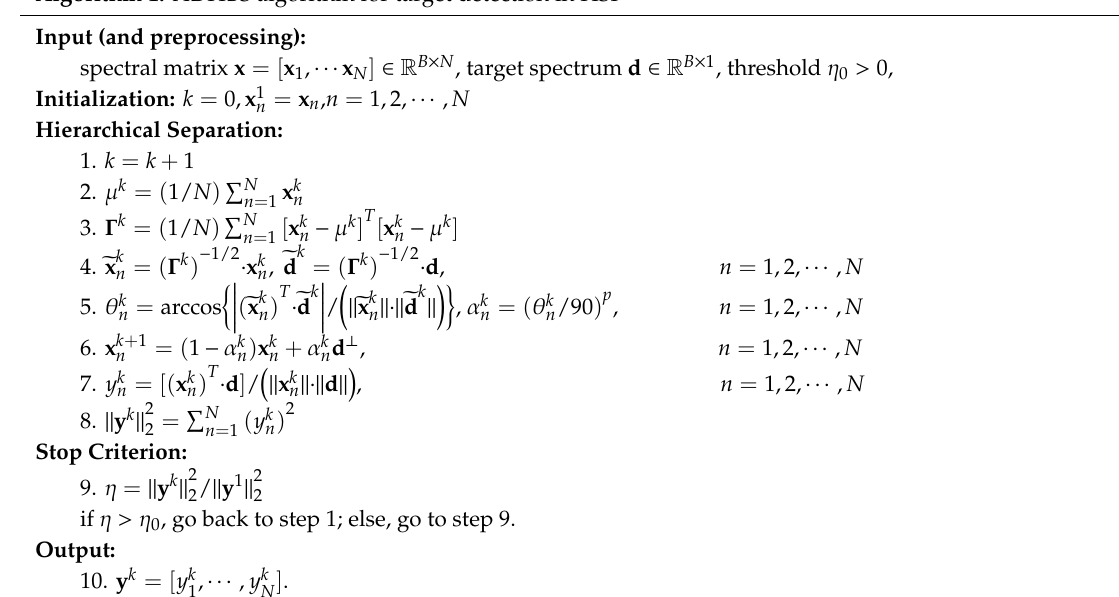
Algorithm 1: ADHBS algorithm for target detection in